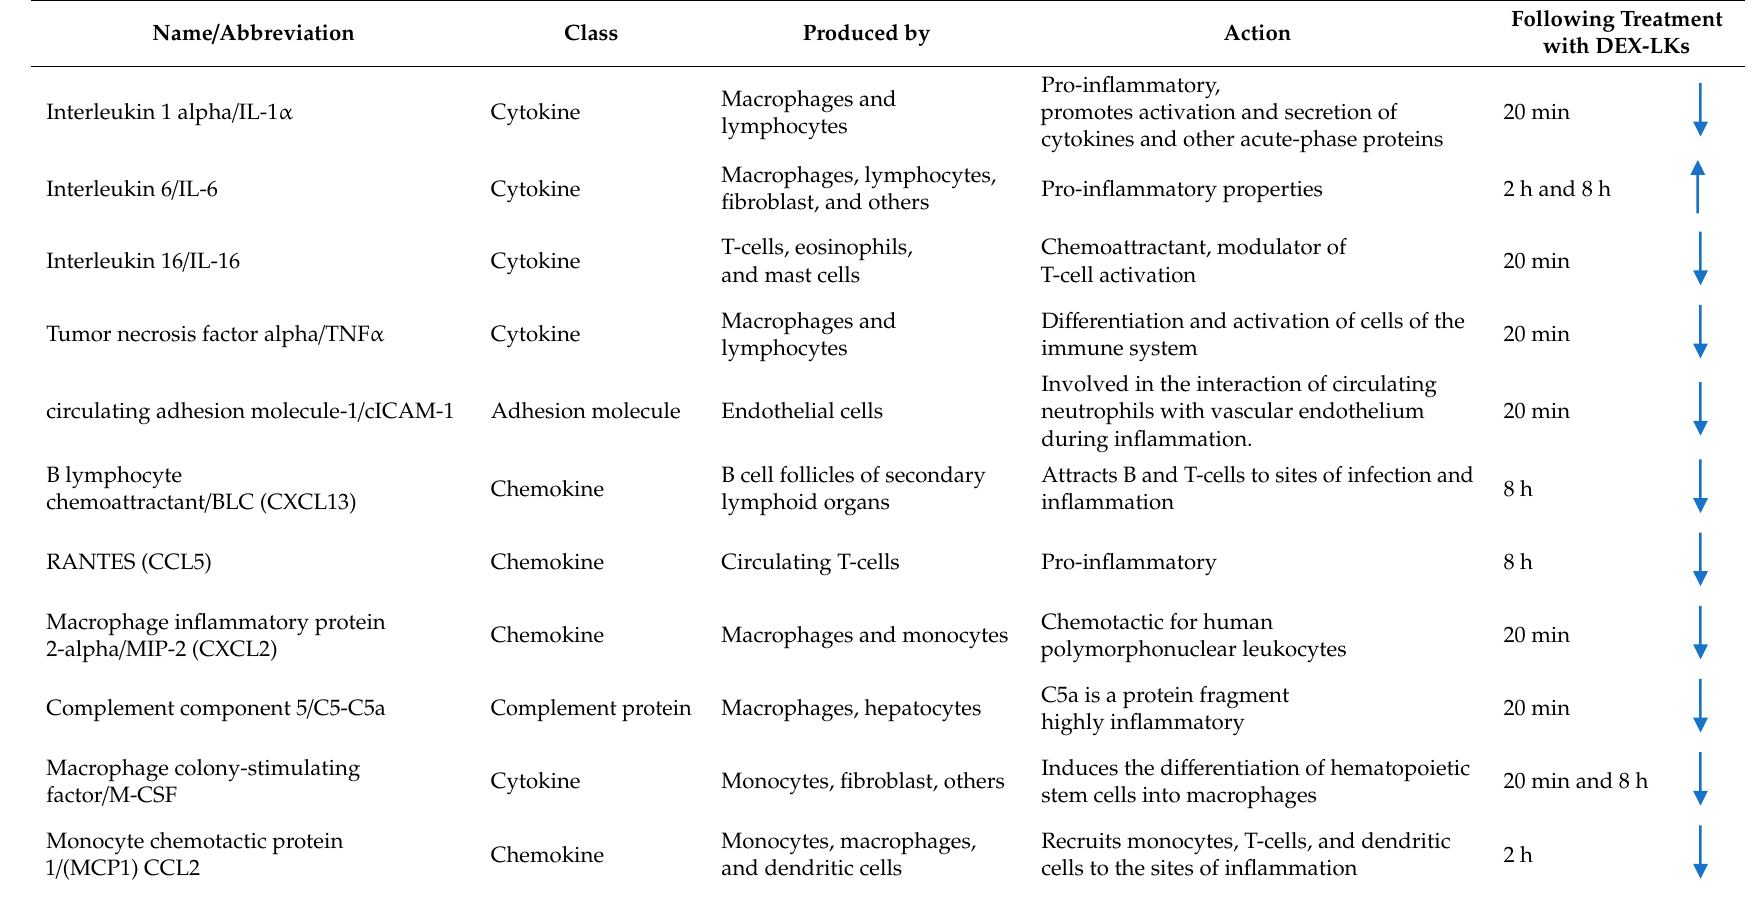
Table 1. List of the cytokines and chemokines detected in the array, reporting their action and their levels following treatment with DEX-LKs compared to free DEX.